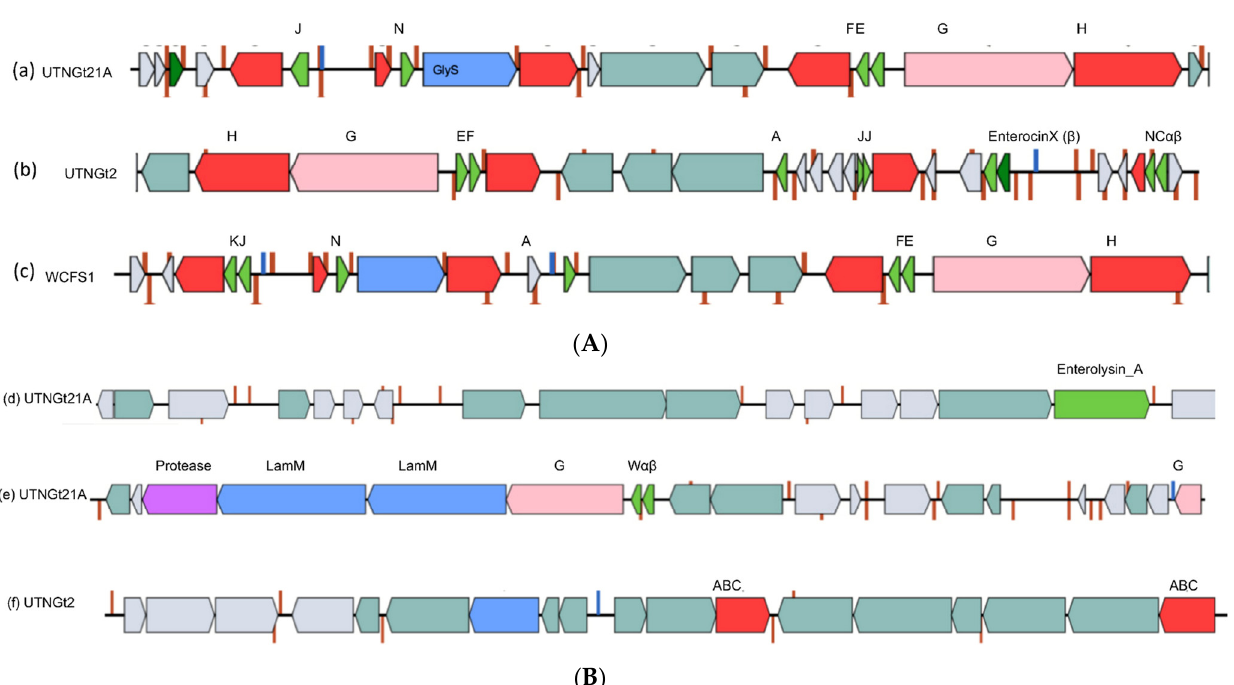
Figure 5. ( A ) Genetic organization of the pln loci of (a) UTNGt21A; (b) UTNGt2; and (c) WCFS1. ( B ) Additional bacteriocin cluster genes detected on (f) UTNGt21A and (e) UTNGt2. Legend— A: plnA; J: pln J; N: plnN ; K: plnK; E: plnE; F: plnF; NCαβ: NCα and NCβ; enterocinX (β): enterocin X (chain beta); GlyS: glycotransferase family 2 protein (PlnO), LamM: lantibiotic mersacidin-modifying enzyme; Wαβ: Plantaricin_W (alpha), Plantaricin W (beta); 183.2; Plantaricin_W (beta); ABC: ABC- type bacteriocin transporter. Red blocks: immunity and transport; green arrow: core